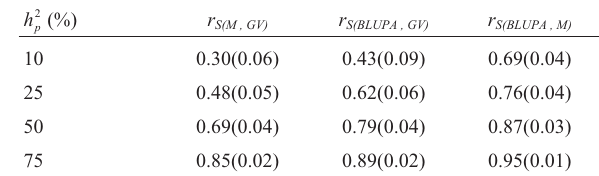
Table 1 - Mean estimates of the genetic variance among F 4:5 progenies Table2 -MeanestimatesoftheSpearmancorrelation( r S )andstandarder- (cid:2) 2 ) and heritability on a F 2 ) and standard errors rors (in parentheses) between genotypic values ( GV ), phenotypic means ( (cid:2) σ h 4:5 progeny mean basis ( p p ( M ) and BLUP predictions considering the additive parentage ( BLUP A ) (valuesinbrackets)accordingtomodel G I (ignoringthepedigreeinforma- among F 4:5 progenies, conducted by the pedigree method for different val- tion) and model G A (considering the pedigree information) for different ues of heritability on a F 4:5 progeny mean basis ( h 2 . values of heritability h p